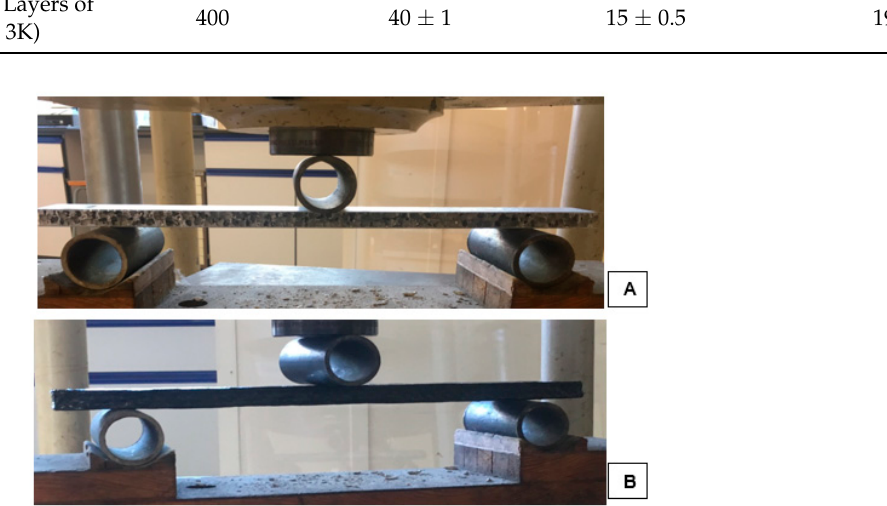
Figure 11. The large scale three-point bending test on ( A ) closed-cell AFSS and ( B ) closed-cell AFSS wrapped around four layers of CFRP (XPREG ® XC110 3K).